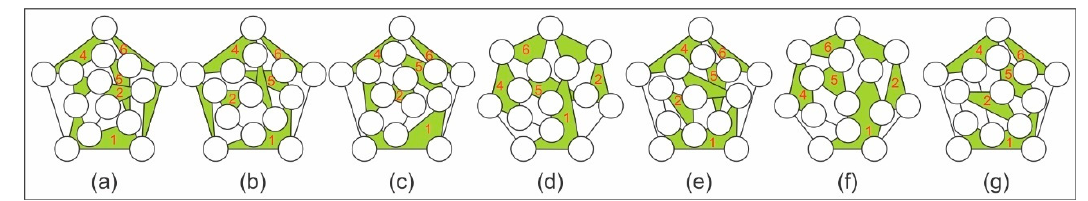
Figure 8. Feasible generalized kinematic chains.